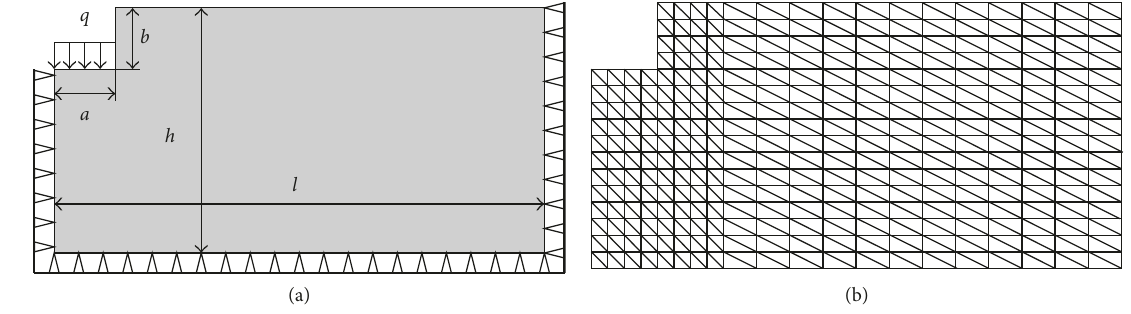
Figure 9: Geometry (a) and mesh (b) of the soil under a deep rigid strip footing.